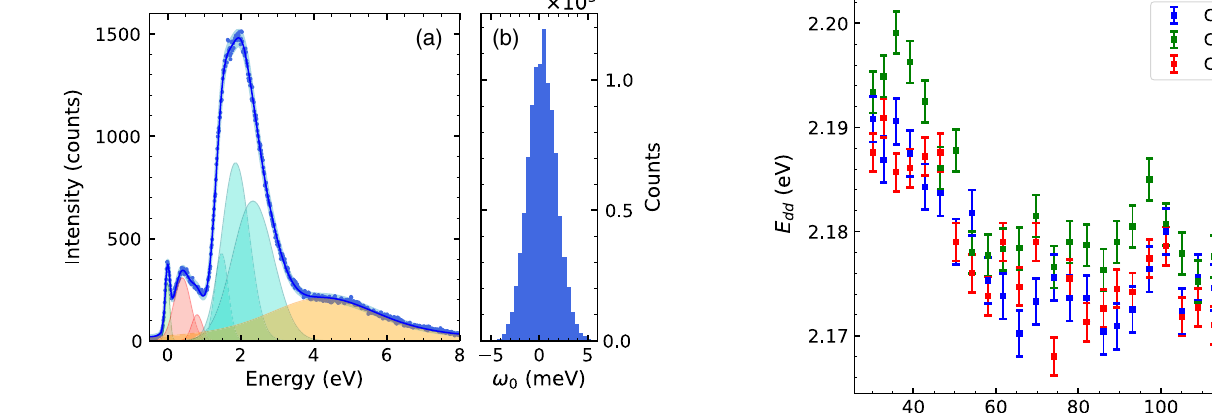
FIG. 7. (a) Fitted spectrum for the OD 70 K q ¼ ð 0 . 36 ; 0 Þ at 30 K; the shaded area indicates the Poissonian noise. The shaded Voigt peaks represent the decomposition of the spectrum. (b) Distribution of the elastic peak position extracted by fitting 10 4 spectra with random Poissonian noise.